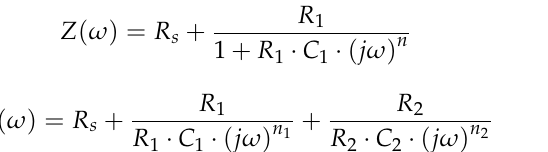
Figure 4. Impedance spectra for selected oxide films grown with different anodization voltage, ob- tained in 1.0 M H 2 SO 4 . ( a ) Phase shift, ( b ) magnitude of the impedance.